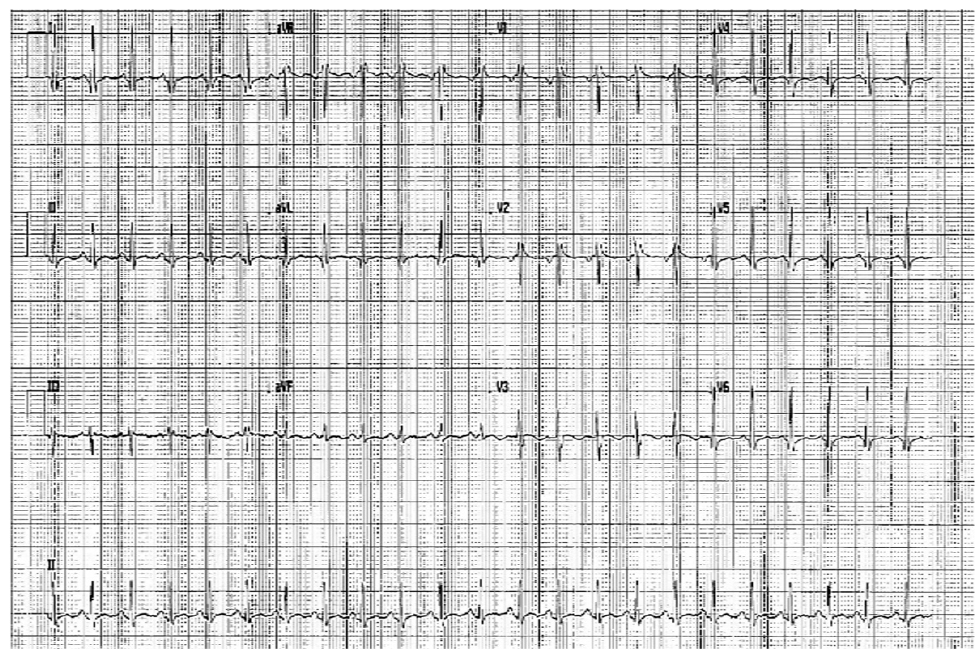
Figure 1. The 12 ‐ leads ECG performed at admission. Figure 1. The 12-leads ECG performed at